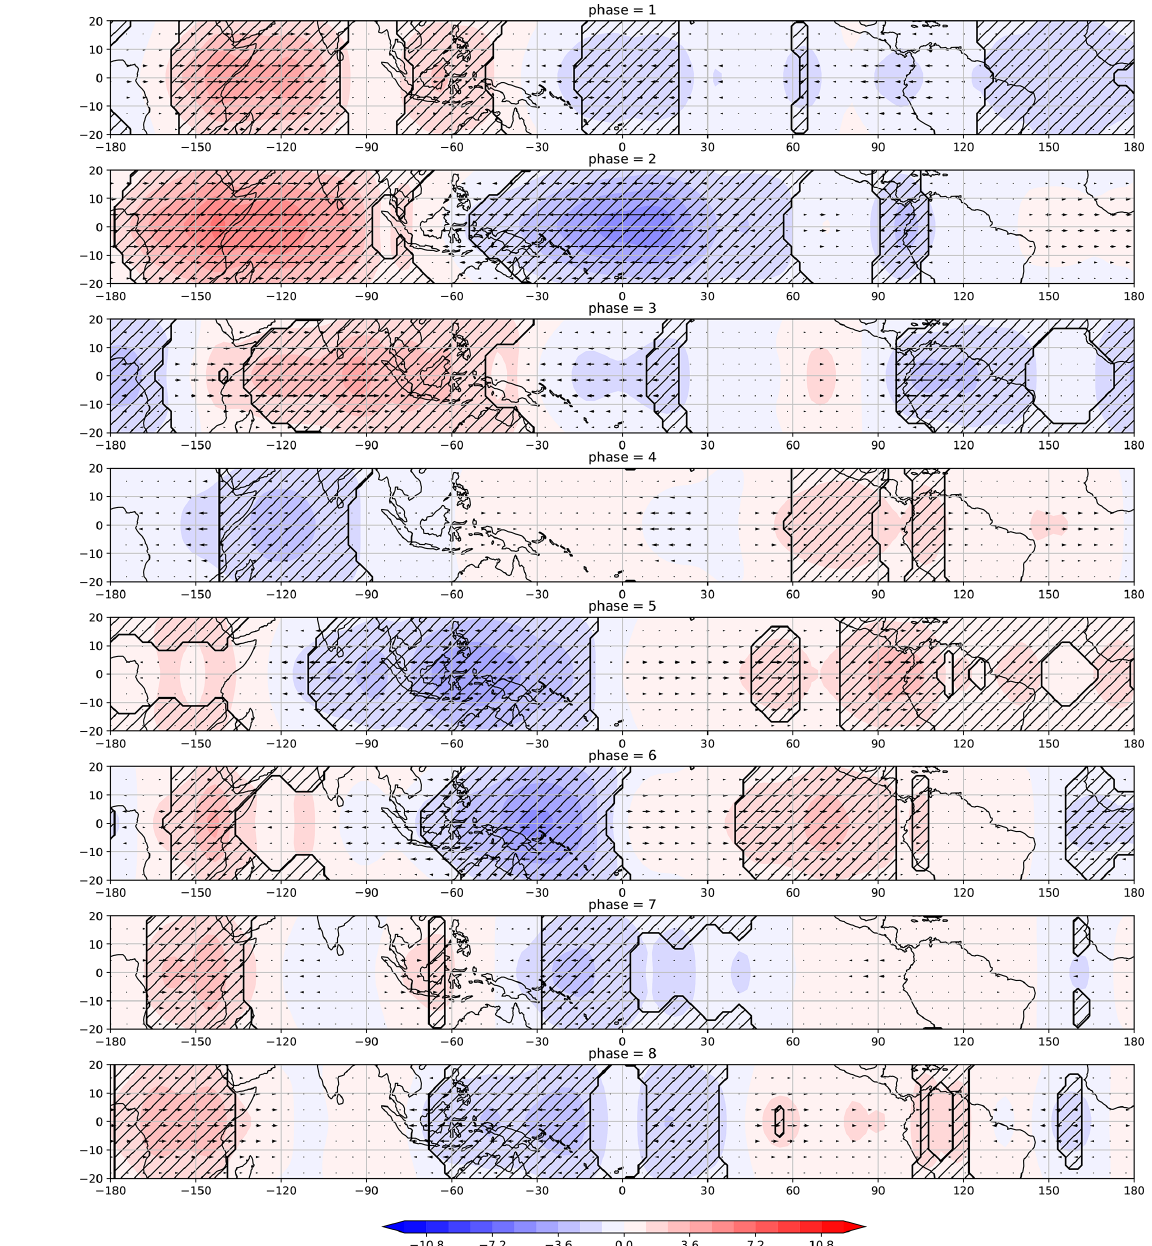
Figure 15. Difference between the velocity and geopotential height fields associated with Kelvin modes with SZW30 + and SZW30 − . The hatched region corresponds to a significant difference of the geopotential height values under the 5% confidence